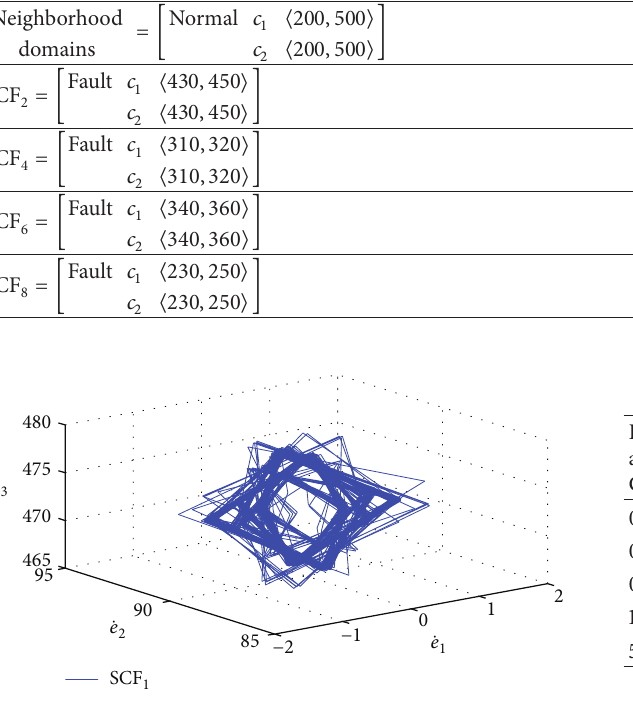
Table 4: Chaotic dynamic trajectory matter-element model.